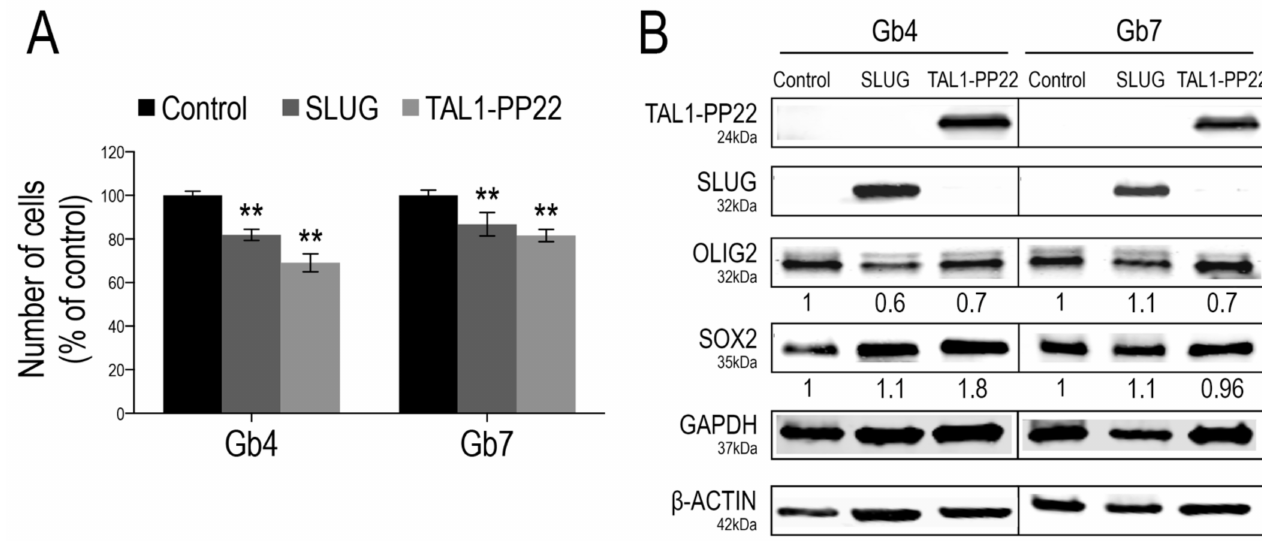
Figure 6. SLUG and TAL1-PP22 overexpression respectively reduce GSC growth. ( A ) Cell counts of Gb4 and Gb7 cells 5 days after transduction of Control, SLUG or TAL1-PP22-overexpressing lentiviruses. Data is shown as a % of the control condition and is representative of 3 independent experiments, n = 5 wells per conditions. Statistical analyses using rank Mann–Whitney tests, **, p < 0.01. ( B ) WB analyses of Gb4 and Gb7 cells after SLUG or TAL1-PP22 overexpression, showing no mutual modulation of expression and no significant change in OLIG2 and SOX2 expression ( n = 1). Control for overexpression of SLUG and expression of SOX2 was normalized to β -actin; control for TAL1-PP22 overexpression and expression of OLIG2 was normalized to